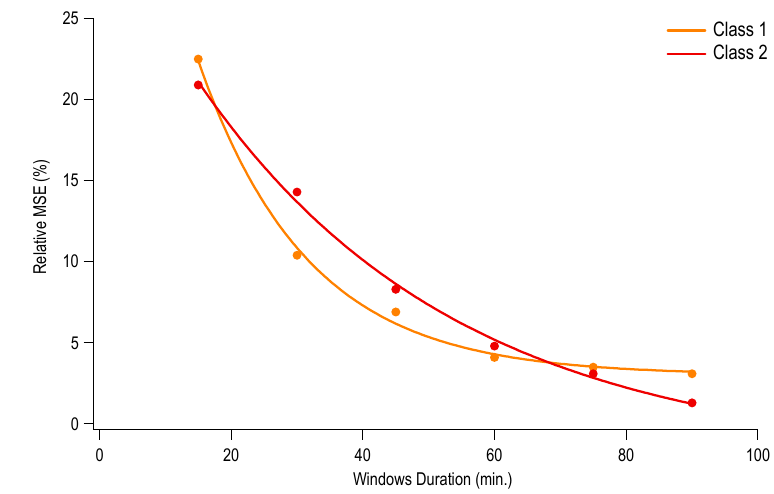
Figure 5. Relative mean squared error (MSE), indicating the difference between mean values of the time spent in trunk flexion and the mean “True” value (from the full 2-h sample). Values are given for several window durations (i.e., 15, 30, 45, 60, 75, and 90 min). Exponential curve fits are indicated by solid lines.